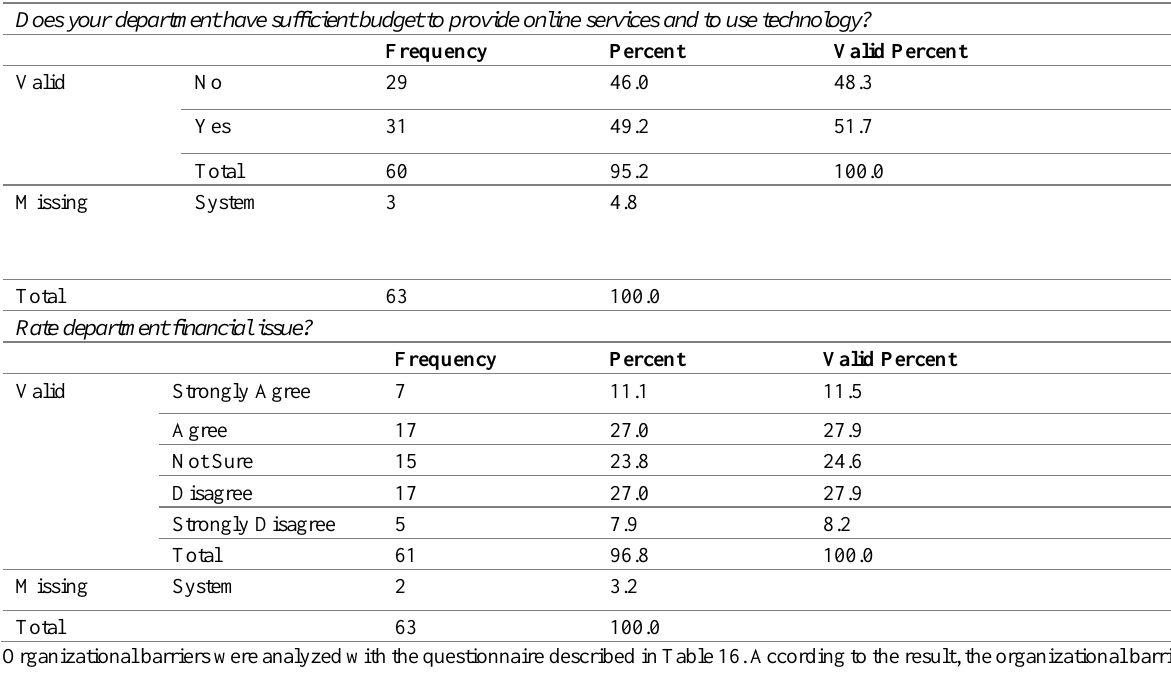
Table 15: Results of Questionnaire Processing Related to Financial Barrier